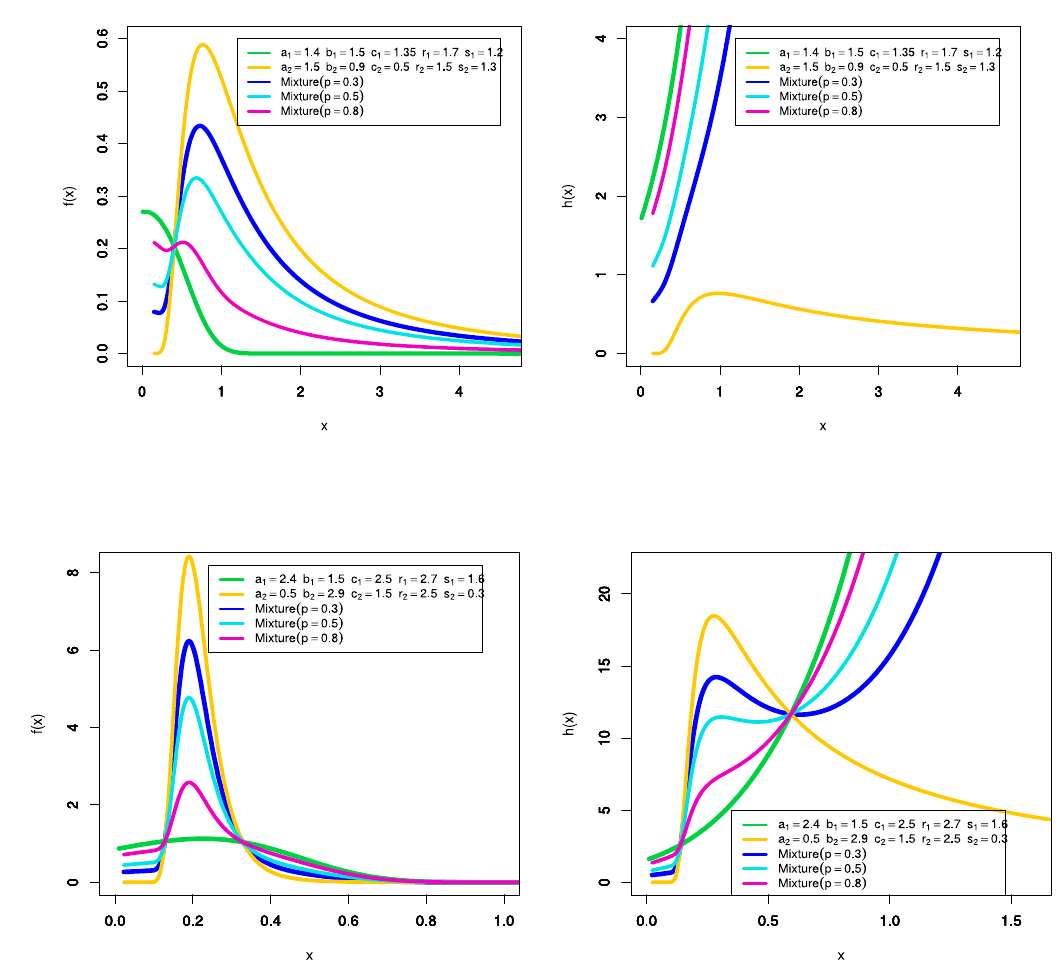
Figure 1. Some representative PDF and hrf plots MEKGEKF